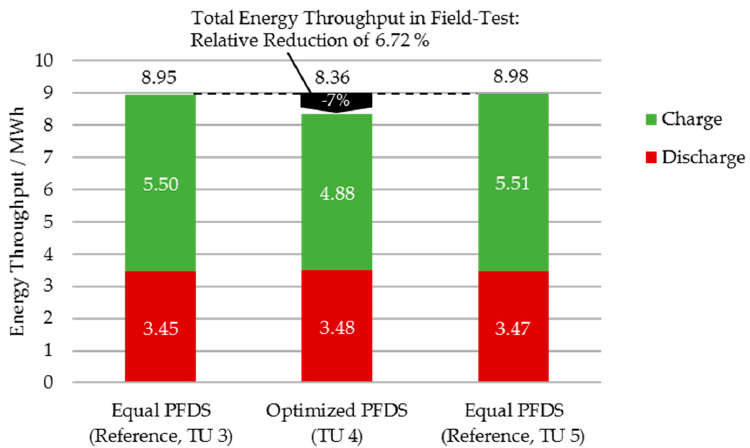
Figure 9. Field-test results for energy throughput (AC-measurement, charge/discharge) of Technical Units (TUs) 3–5 for 3–14 August 2017. TU 3 and TU 5 operate on equal Power Flow Distribution Strategy (PFDS); TU 4 operates on optimized PFDS.